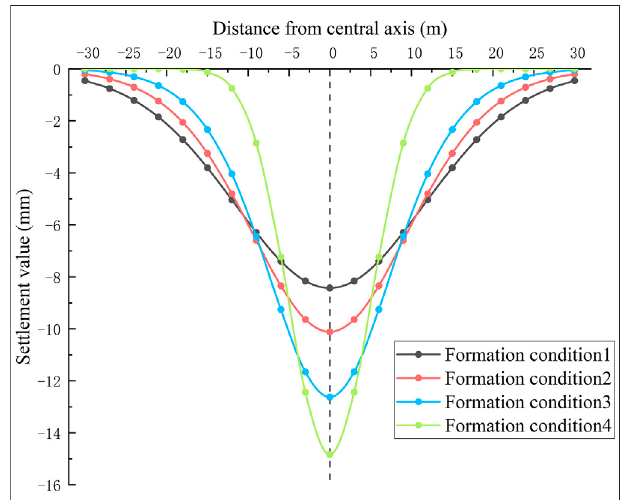
FIGURE 14 | In fl uence of different soil layer conditions on surface